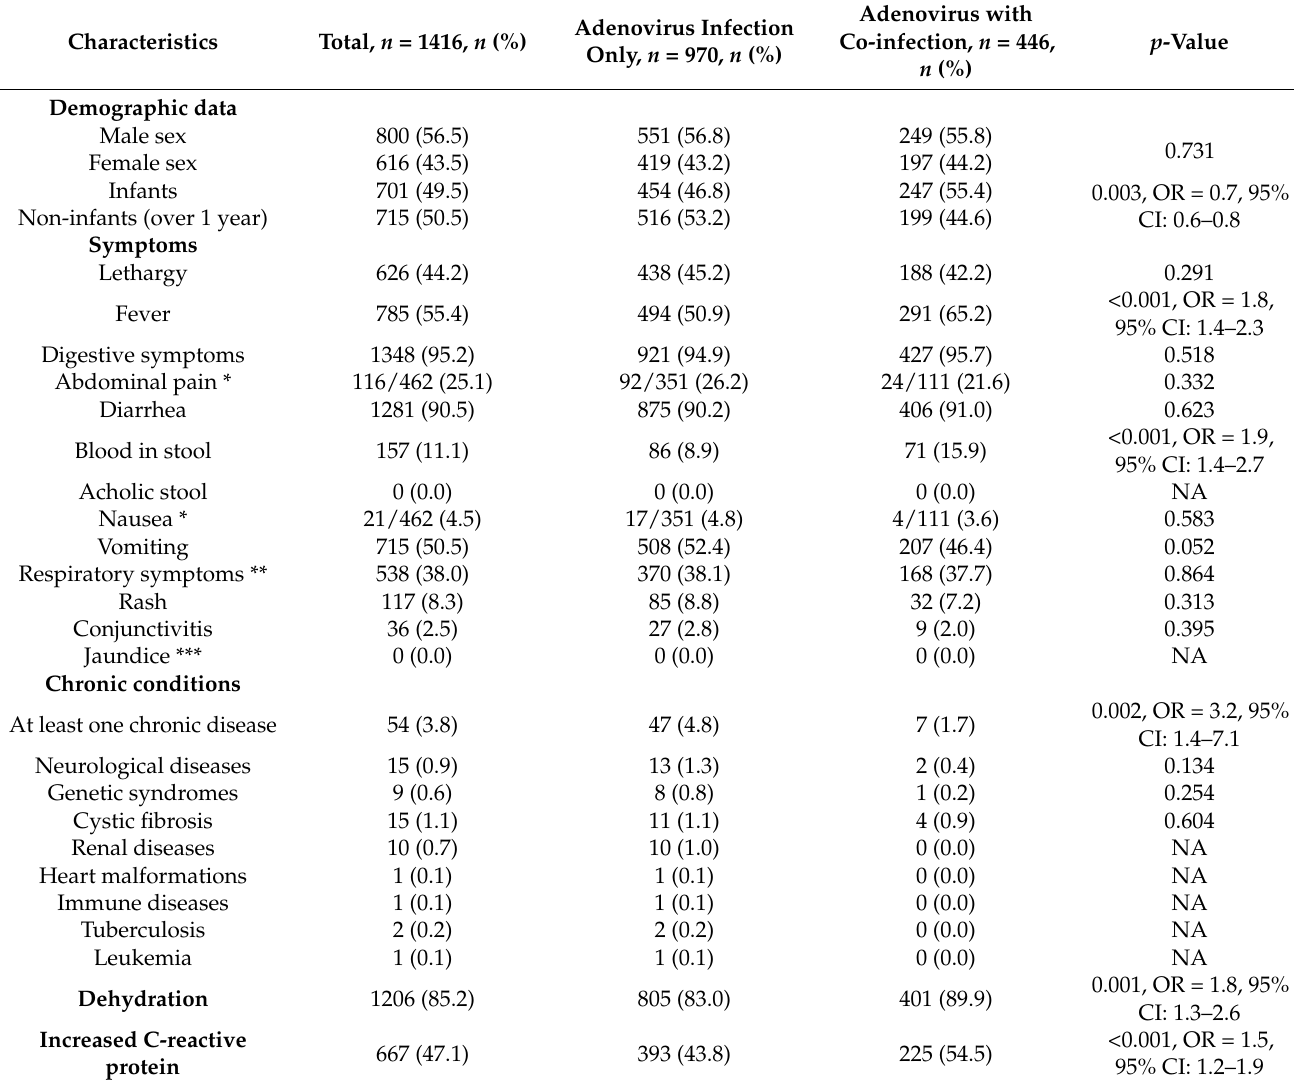
Figure 2. Distribution of symptoms in pediatric patients with adenovirus infection. Table 1. Characteristics of the studied group.